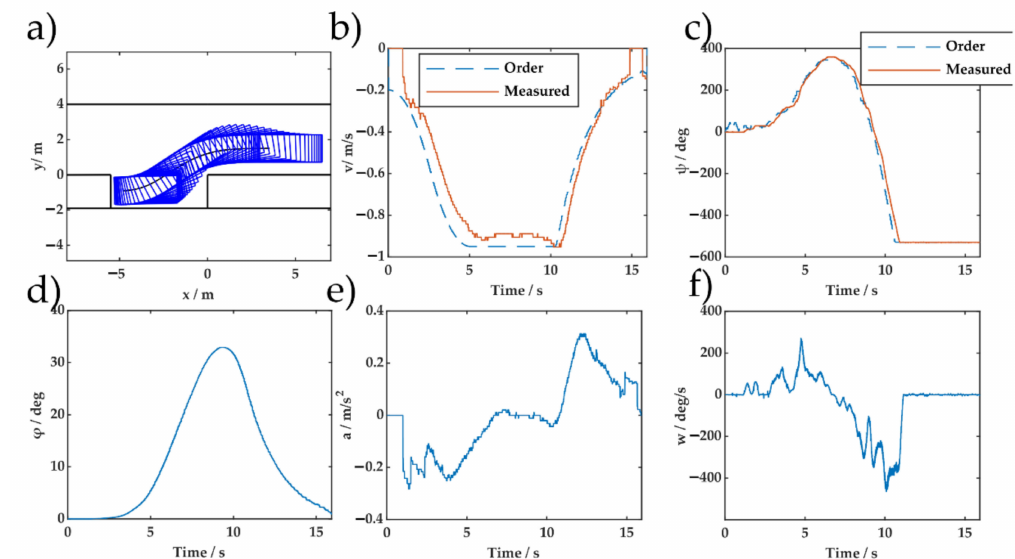
Figure 14. Experimental parking control and state profiles of DERL for the initial pose (3.5 m, 1.5 m, 0): ( a ) Parking trajectory; ( b ) speed profile; ( c ) steering wheel angle profile; ( d ) orientation angle; ( e ) acceleration; and ( f ) steering wheel